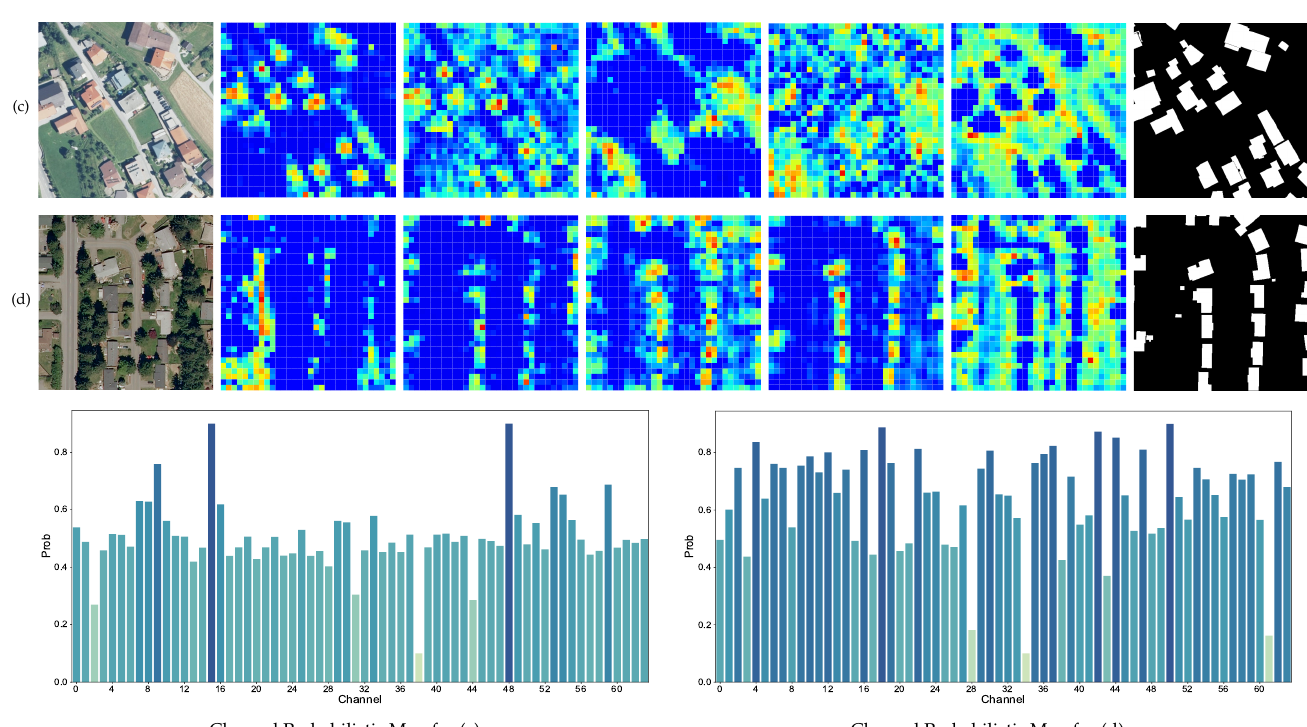
Figure 6. Visualization of channel probabilistic maps and their importance values. There are 4 samples from WHU and INRIA datasets. The left-most column shows input images. The right-most column shows the ground truth labels. The channel importance bars are plotted below for each images. The other 5 columns shows the heatmaps, which are taken from feature extractor with pixel resolution of 32 × 32 according to the channel probabilistic map. Here, we only pick the top-5 for